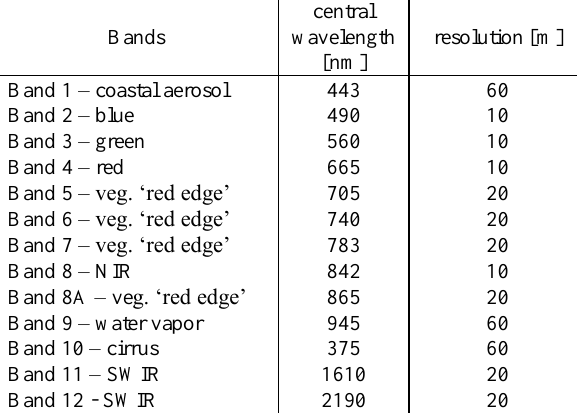
Table 1: Sentinel-2 central wavelengths and resolution of the 13 bands (after ESA, 2017b) Bands